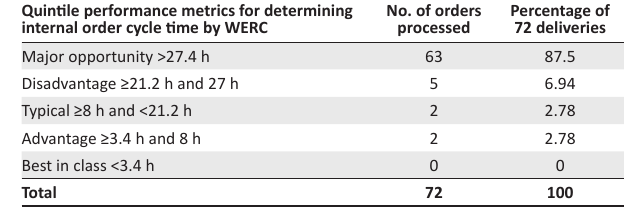
TABLE 6: Internal order cycle